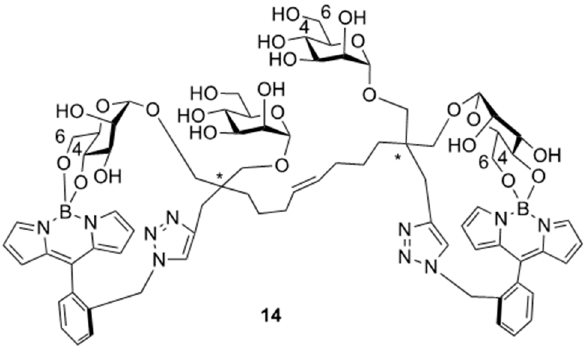
Figure 2. Fluorescently-labeled tetramannan derivative ( 14 ).